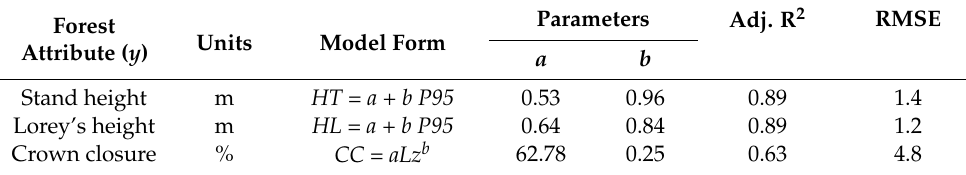
Table 2. Airborne laser scanning models, parameters, and goodness-of-fit metrics (adjusted (Adj.) R 2 , root mean square error (RMSE)) ( n = 38) (stand height and crown closure first reported in Mahoney et al. [8]). P95, height corresponding to the 95th percentile of points 2 m above the ground. Lz, absolute natural logarithm of the proportion of points above 2 m.